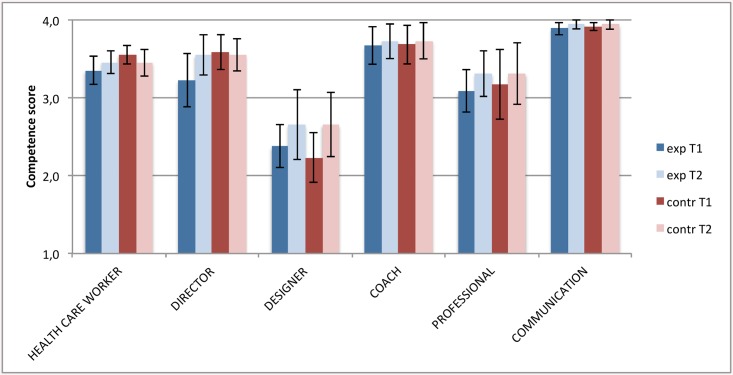
Competence development of general roles nurse, experiment and control regions compared.T1 = at the start of the training, T2 = after one year experience with the new working method. Exp = experiment region, contr = control region. The 95% confidence intervals are indicated by black error bars.